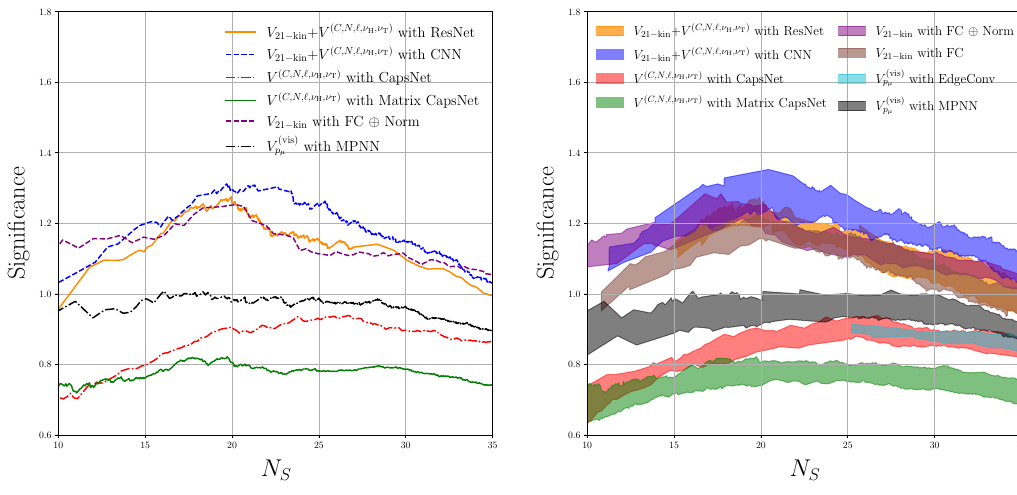
Figure 12 . (left) Significance of observing double Higgs production at the HL-LHC with L = 3 ab − 1 for various NNs, taking the best model for each type. (right) Variation of the final results with 10 independent runs for the same NNs but different initial values of